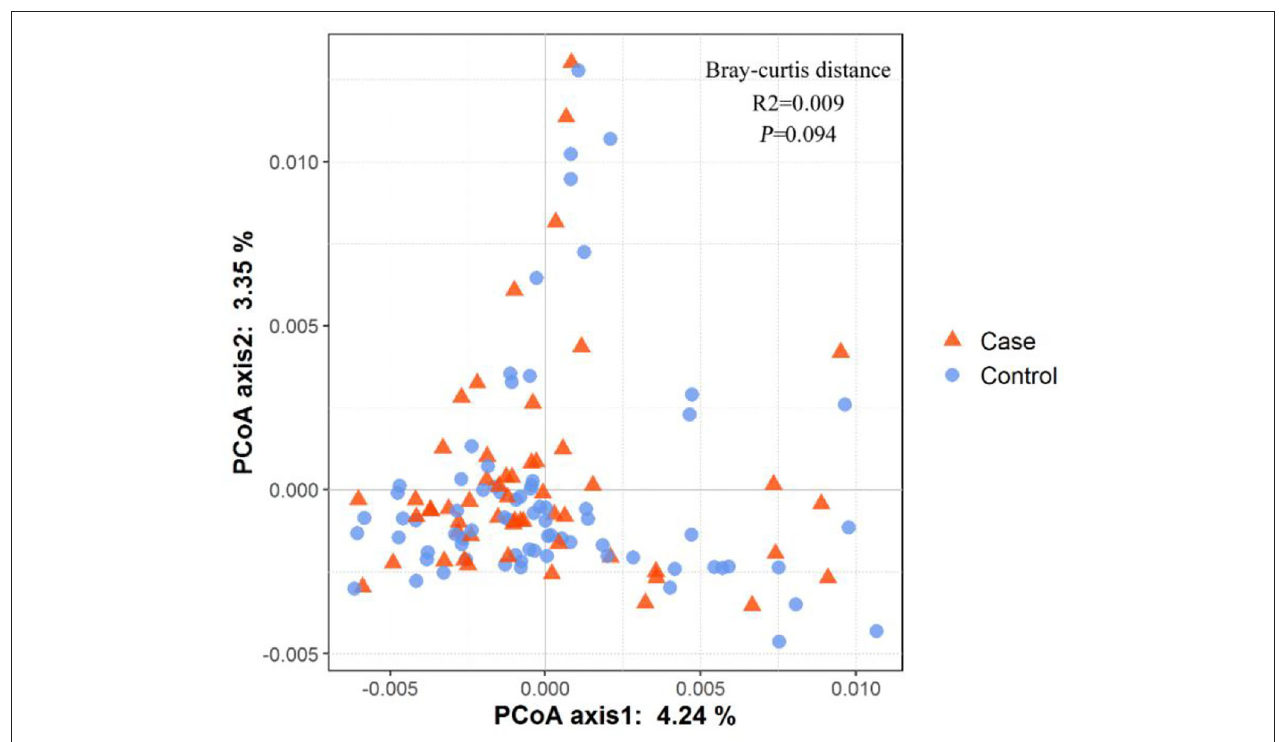
FIGURE 2 | The beta-diversity of gut microbiota between the two groups.